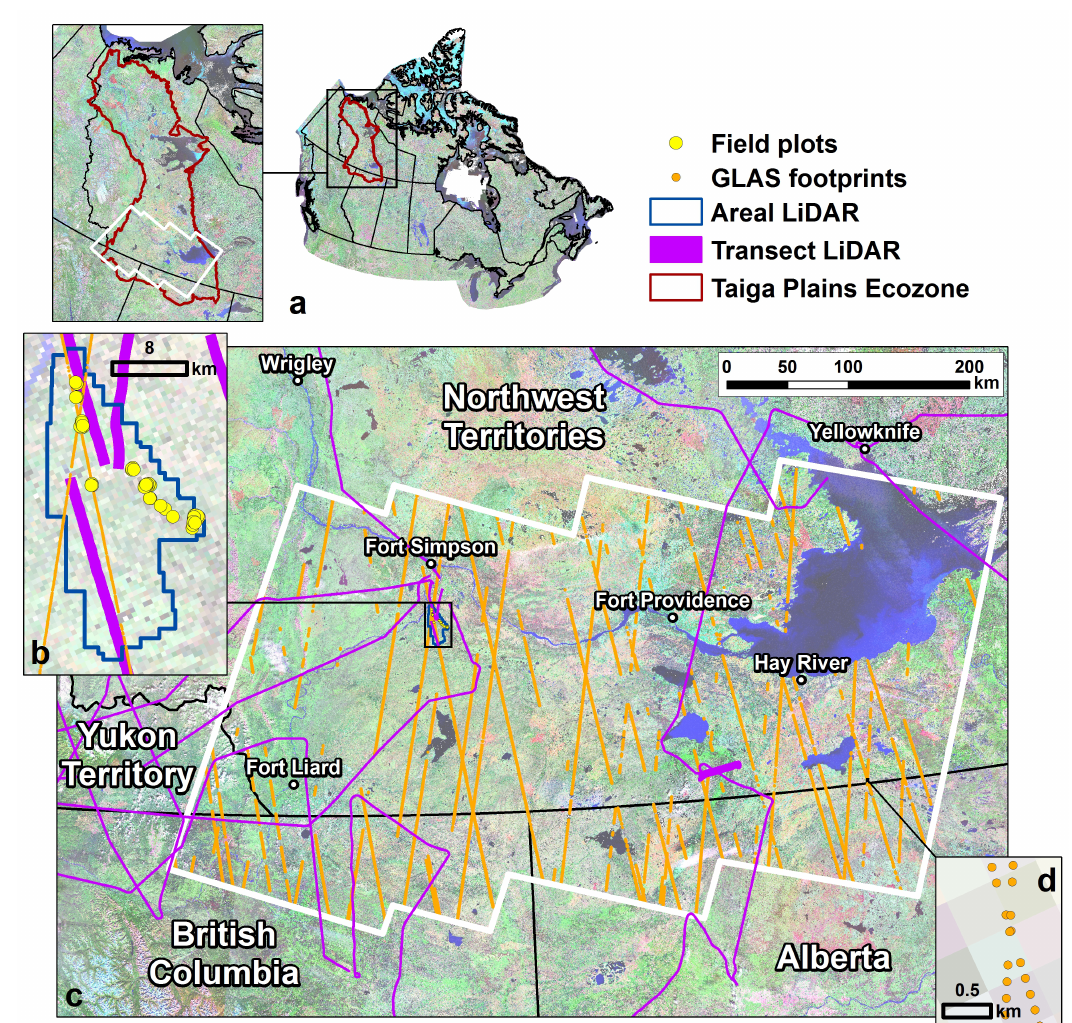
Figure 1. Study site location and data distribution: ( a ) the study site and Taiga Plains ecozone within Canada; ( b ) field plot locations with respect to the areal LiDAR extent, and overlapping transect LiDAR and Geoscience Laser aLtimeter System (GLAS) footprints; ( c ) the distribution of areal and transect LiDAR, and GLAS footprints throughout the study site; and ( d ) along orbit GLAS footprint separation (note points represent footprint centres, not